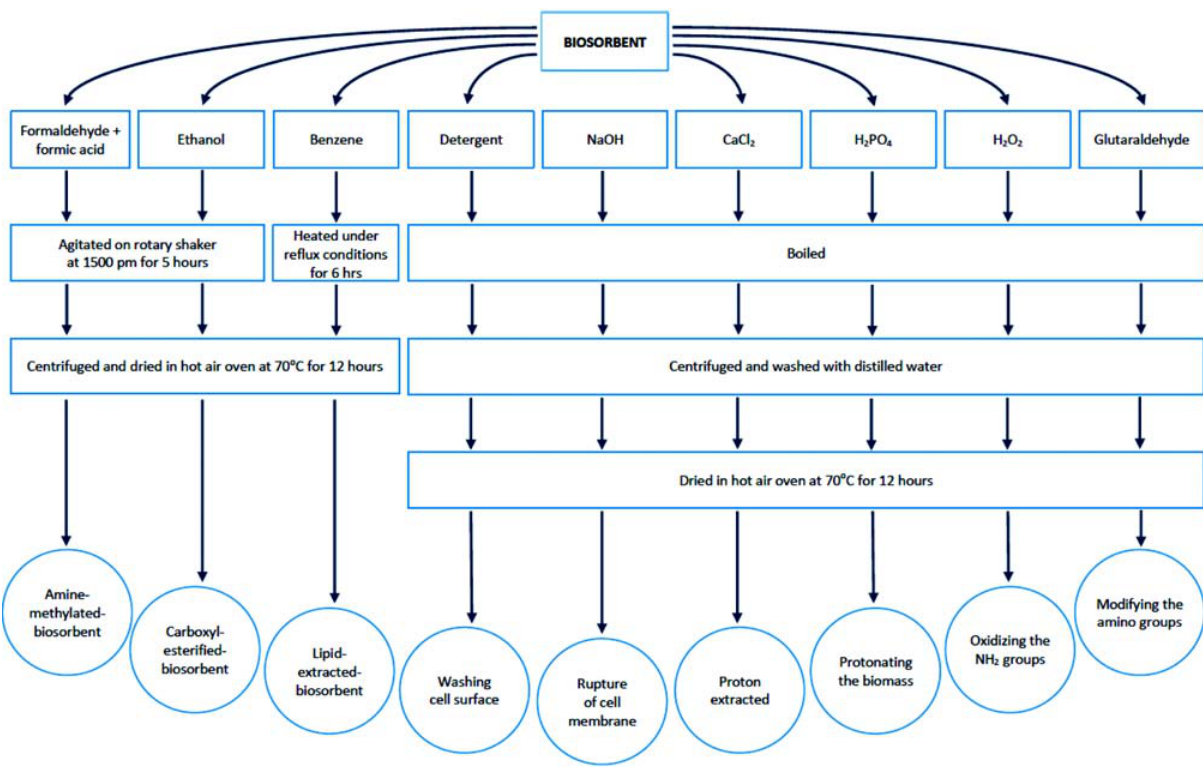
Fig. 1. Schematic representation of the chemical treatments performed on waste brewery